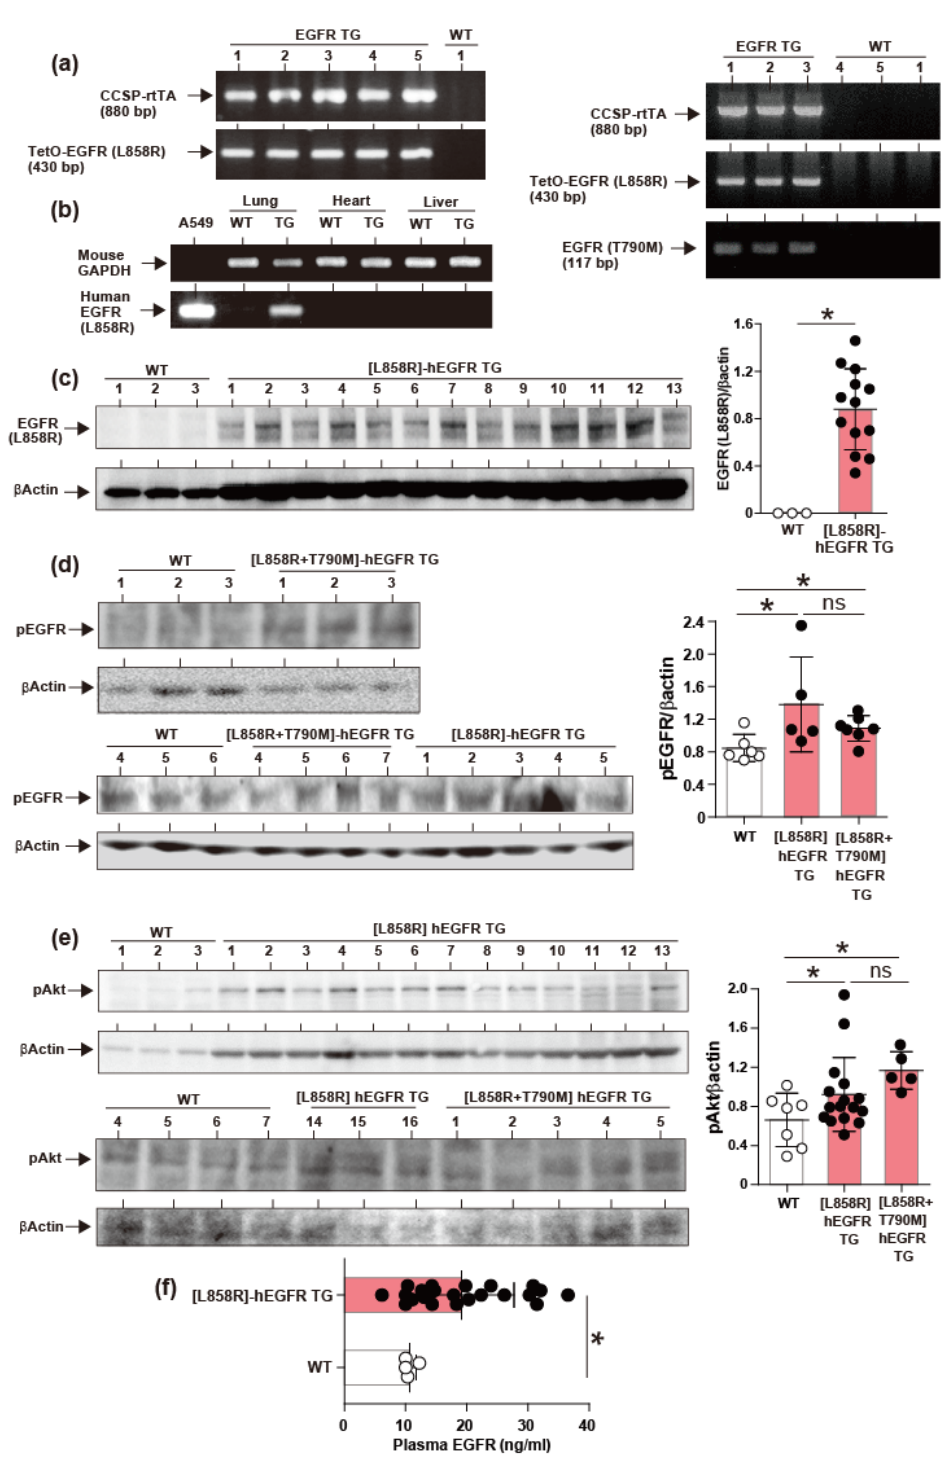
Figure 2. Lung-specific activation of mutant EGFR and phosphorylation of intracellular signal pathways. ( a,b ) Genotyping of bitransgenic mice and lung-specific expression of mutant EGFR. The uncropped Western blots have been shown in the Figure S4. ( c – e ) Increased expression of the [L858R]-hEGFR protein in [L858R]-hEGFR transgenic mice, phosphorylation of EGFR, and phosphorylation of Akt kinase in both [L858R]-hEGFR and [L858R+T790M] transgenic mice. ( f ) Elevated plasma level of soluble EGFR ( f ) in [L858R]-hEGFR transgenic mice. Data are expressed as the mean ± S.D. Statistical analysis by unpaired Student t -test. * p < 0.05 compared to wild type (WT) mice. hEGFR, human epidermal growth factor